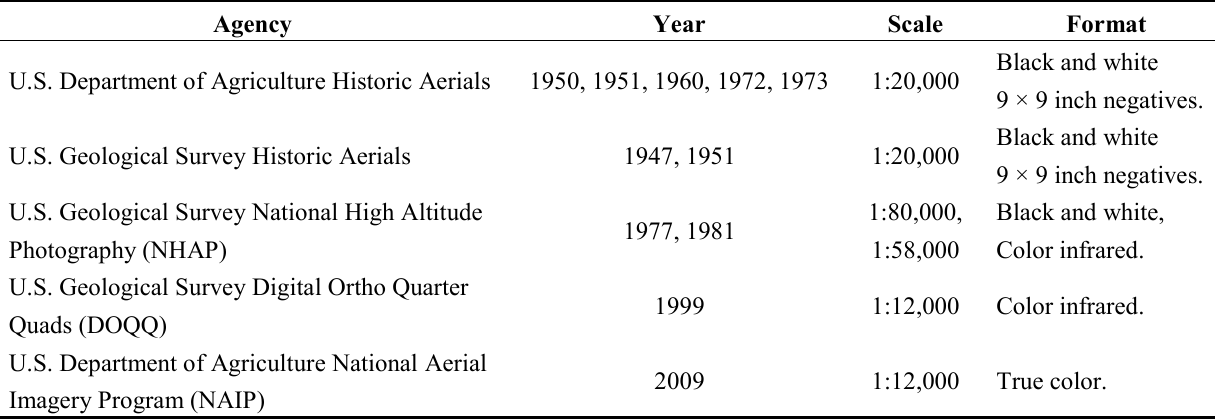
Table 1. Historic imagery agency, year, scale, and